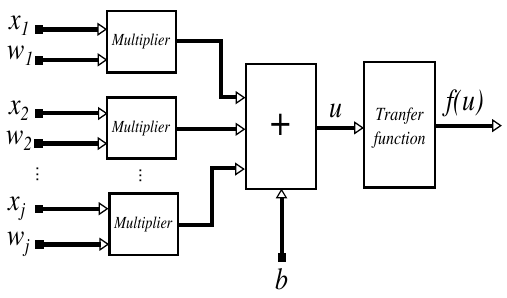
Figure 10. Synthesis of the functional structure of an artificial neuron.